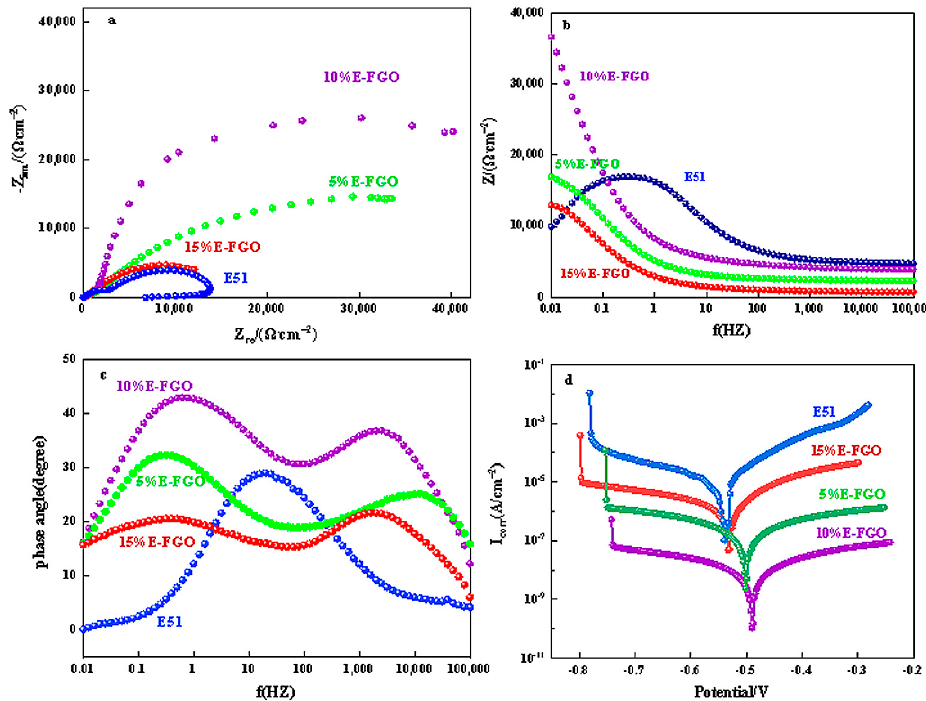
Figure 6. ( a ) Nyquist, ( b , c ) Bode plots and phase angle, ( d ) and Tafel curves of E51 and E-FGO coatings.